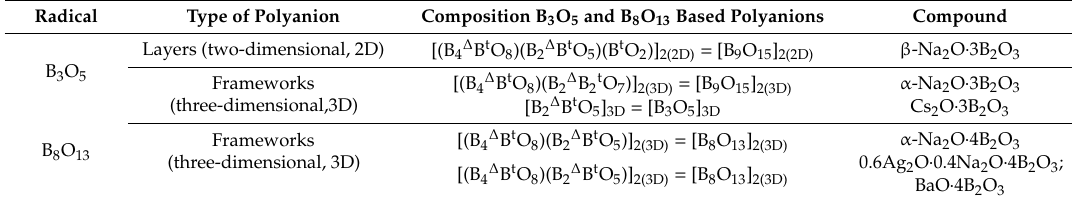
Table 3. Polyanions based on [B 3 O 5 ] n and [B 8 O 13 ] n